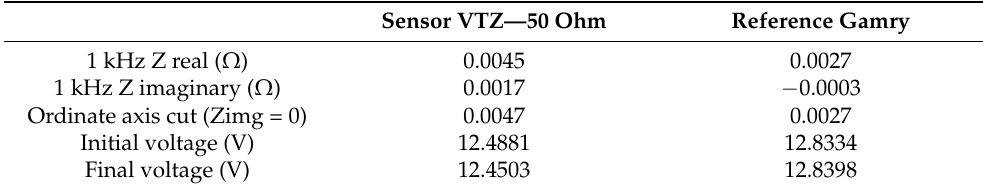
Table 3. Resistances measured at 1 kHz and the voltage parameter variations before and after EIS measurements with the 50 Ω sensor.